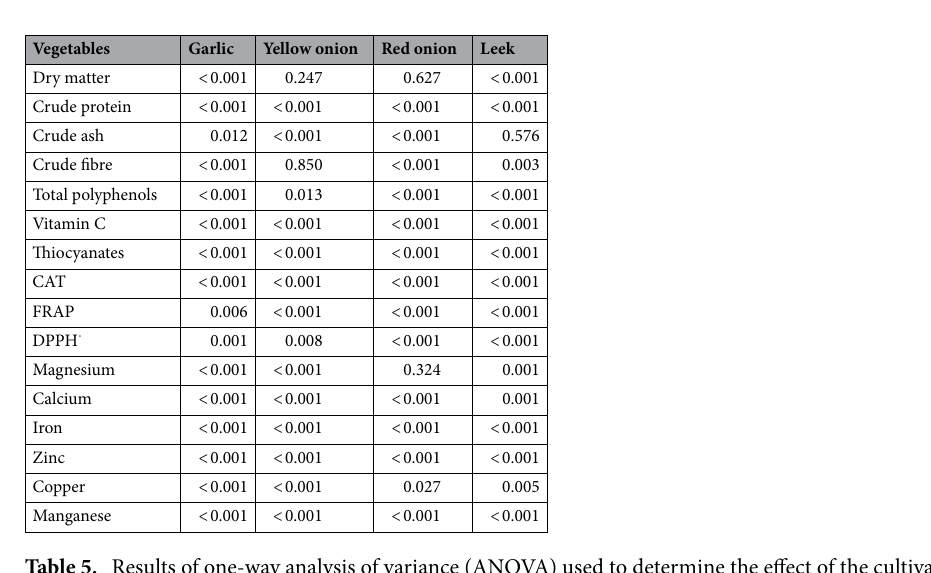
Table 5. Results of one-way analysis of variance (ANOVA) used to determine the effect of the cultivation model (conventional vs. organic) on individual Allium vegetables and on individual parameters included in the